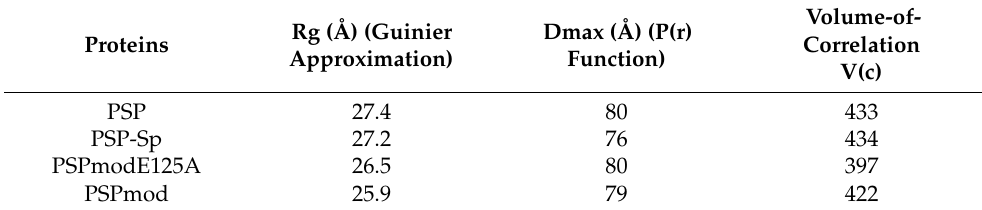
Table 4. SAXS parameters for PSP variants.